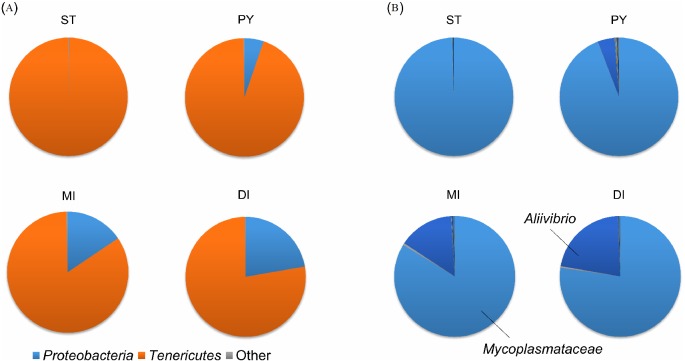
Composition of the bacterial community in the digestive system.Composition of the bacterial community at (A) phylum and (B) genus level. Each sample was pooled from 2–3 salmon. The graphs represent the averages of the various sample types. ST, Stomach (n = 1), PY, Pyloric caeca (n = 6), MI, Mid intestine ( n = 5), DI, Distal intestine (n = 4). Main phyla and genera are indicated.